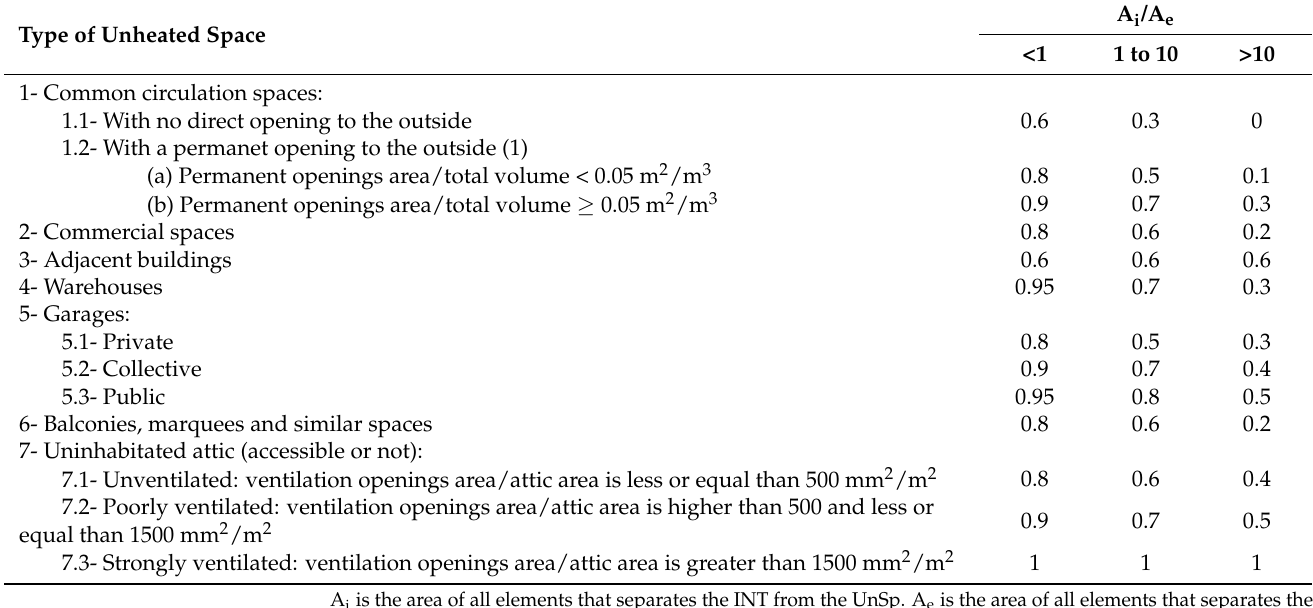
Table 6. Values for the adjustment factor (b), set by the RCCTE:2006 (adapted from [12]). Type of Unheated Space